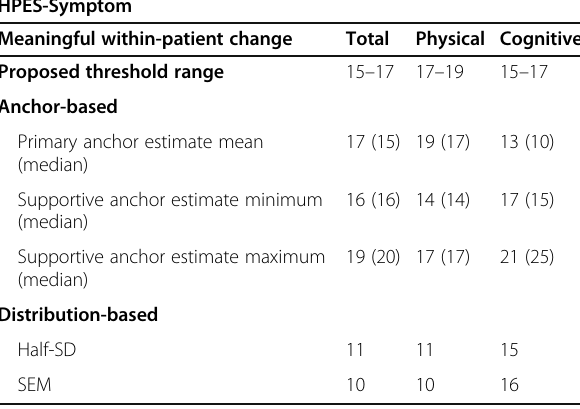
Table 5 Interpretation of change –